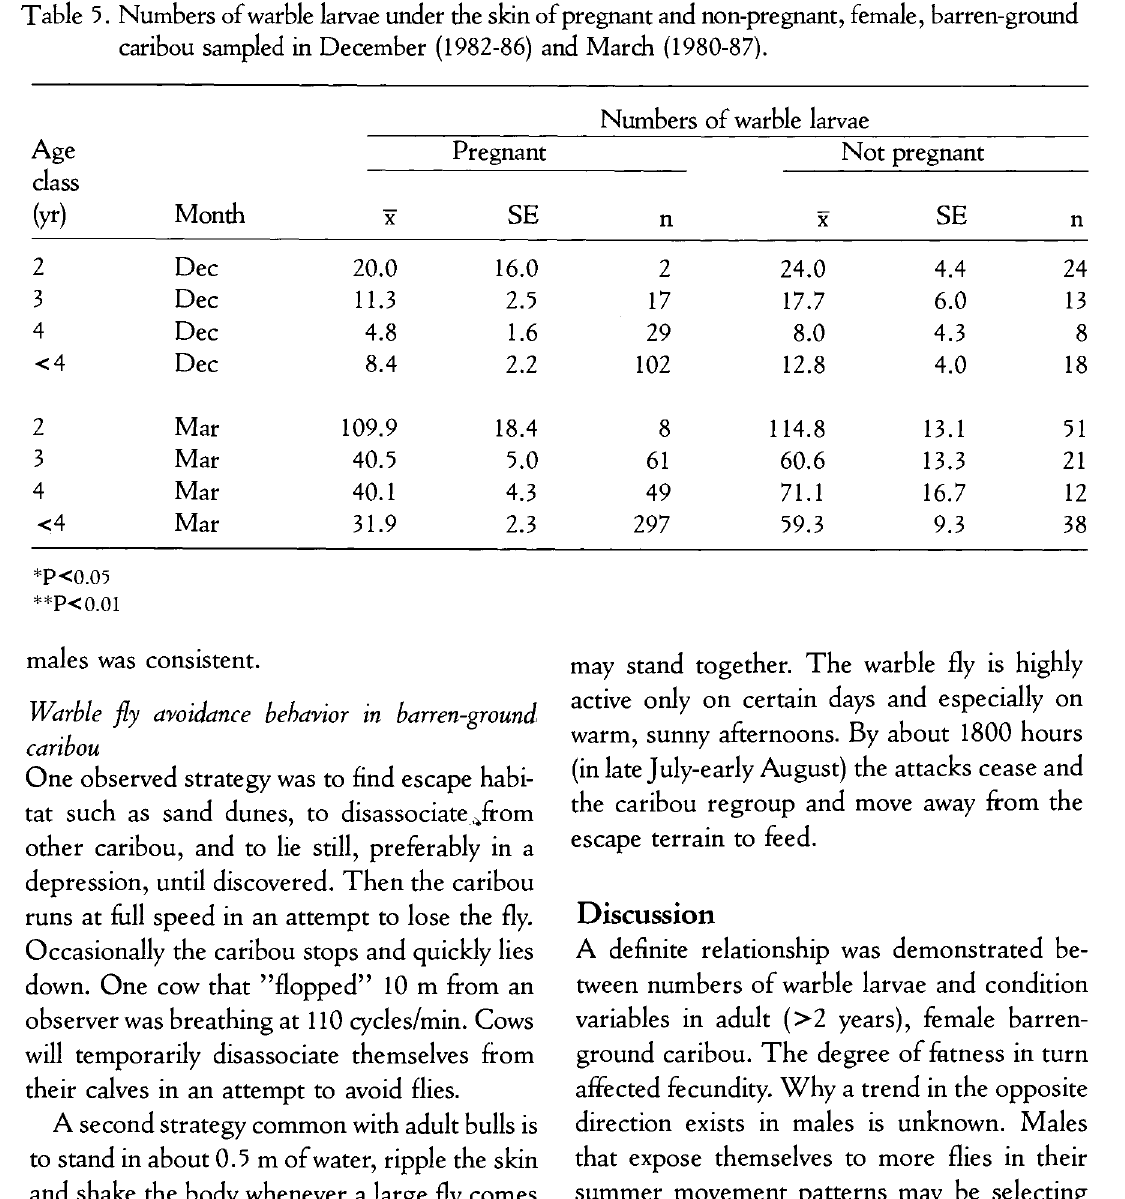
Table 5. Numbers of warble larvae under the skin of pregnant and non-pregnant, female, barren-ground caribou sampled in December (1982-86) and March